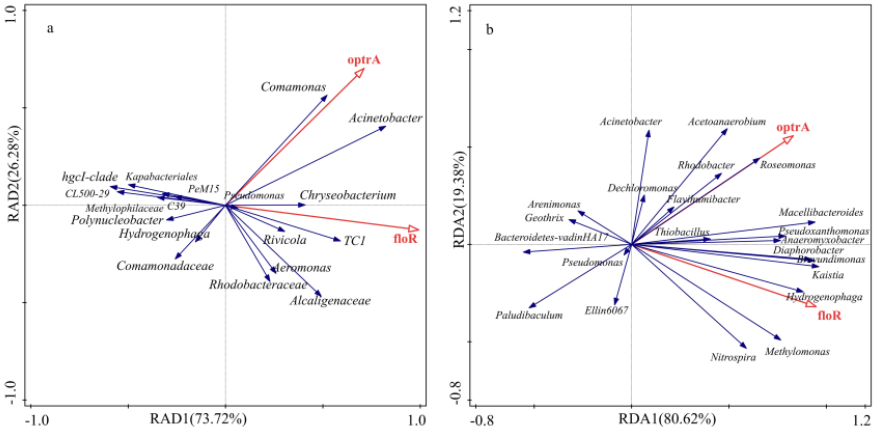
Figure 7. Correlation analysis between bacterial communities and ARGs in an aquatic microcosm model. W, water; S, sediments; ( a ) The results of the redundancy analysis of water samples; ( b ) The results of the redundancy analysis of sediment samples.